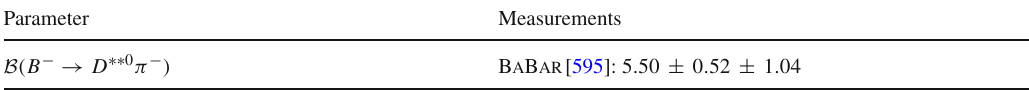
Table 140 Absolute decay rates to excited D mesons [ 10 − 3 ]